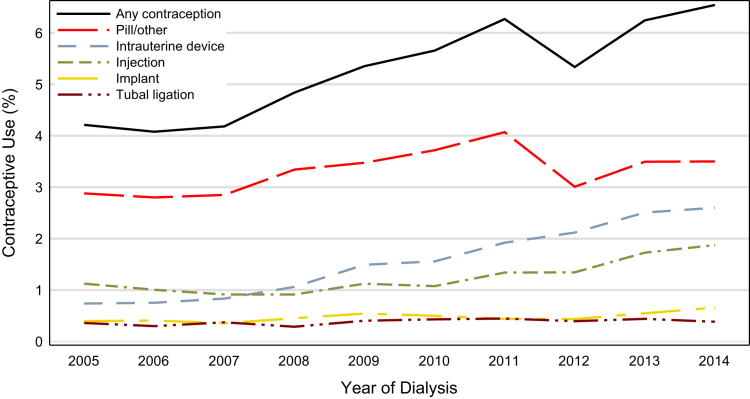
Rates of types of contraceptives use among women with end-stage kidney disease receiving dialysis from 2005 to 2014. Any contraception shows a fairly steady increase across the study time; all categories increase or remain constant from beginning to end. Emergency contraception and diaphragm had rates of <0.10% for all years, not shown in the graph.